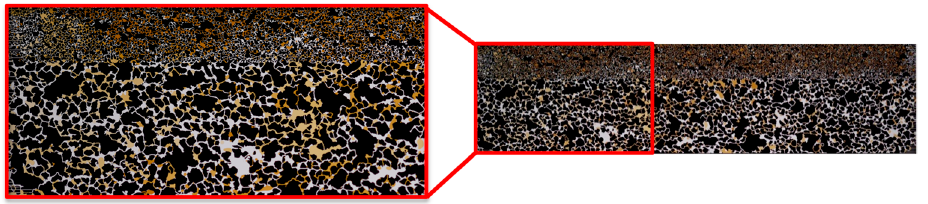
Figure 9. During brine injection, the remaining AP inside the porous structure reacted with the oil and the brine was displaced by an emulsion (light brown), resulting in an increase in pressure.